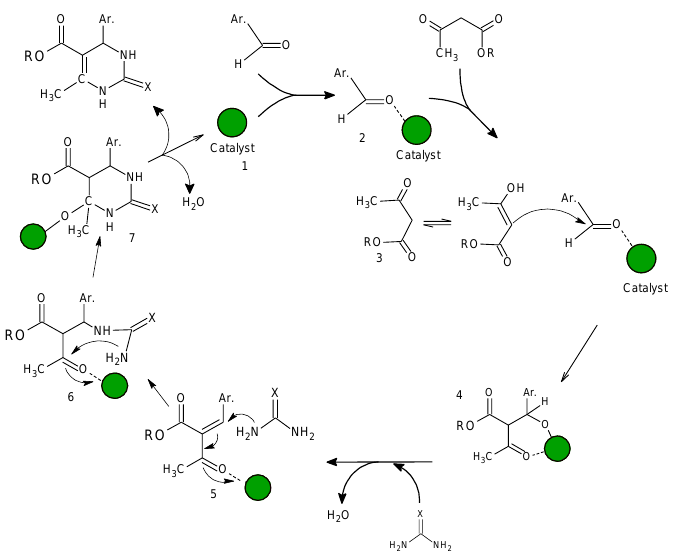
Scheme 2. Reaction mechanism for the formation of 3,4-dihydropyrimidine-2-(1H)-ones/thiones.